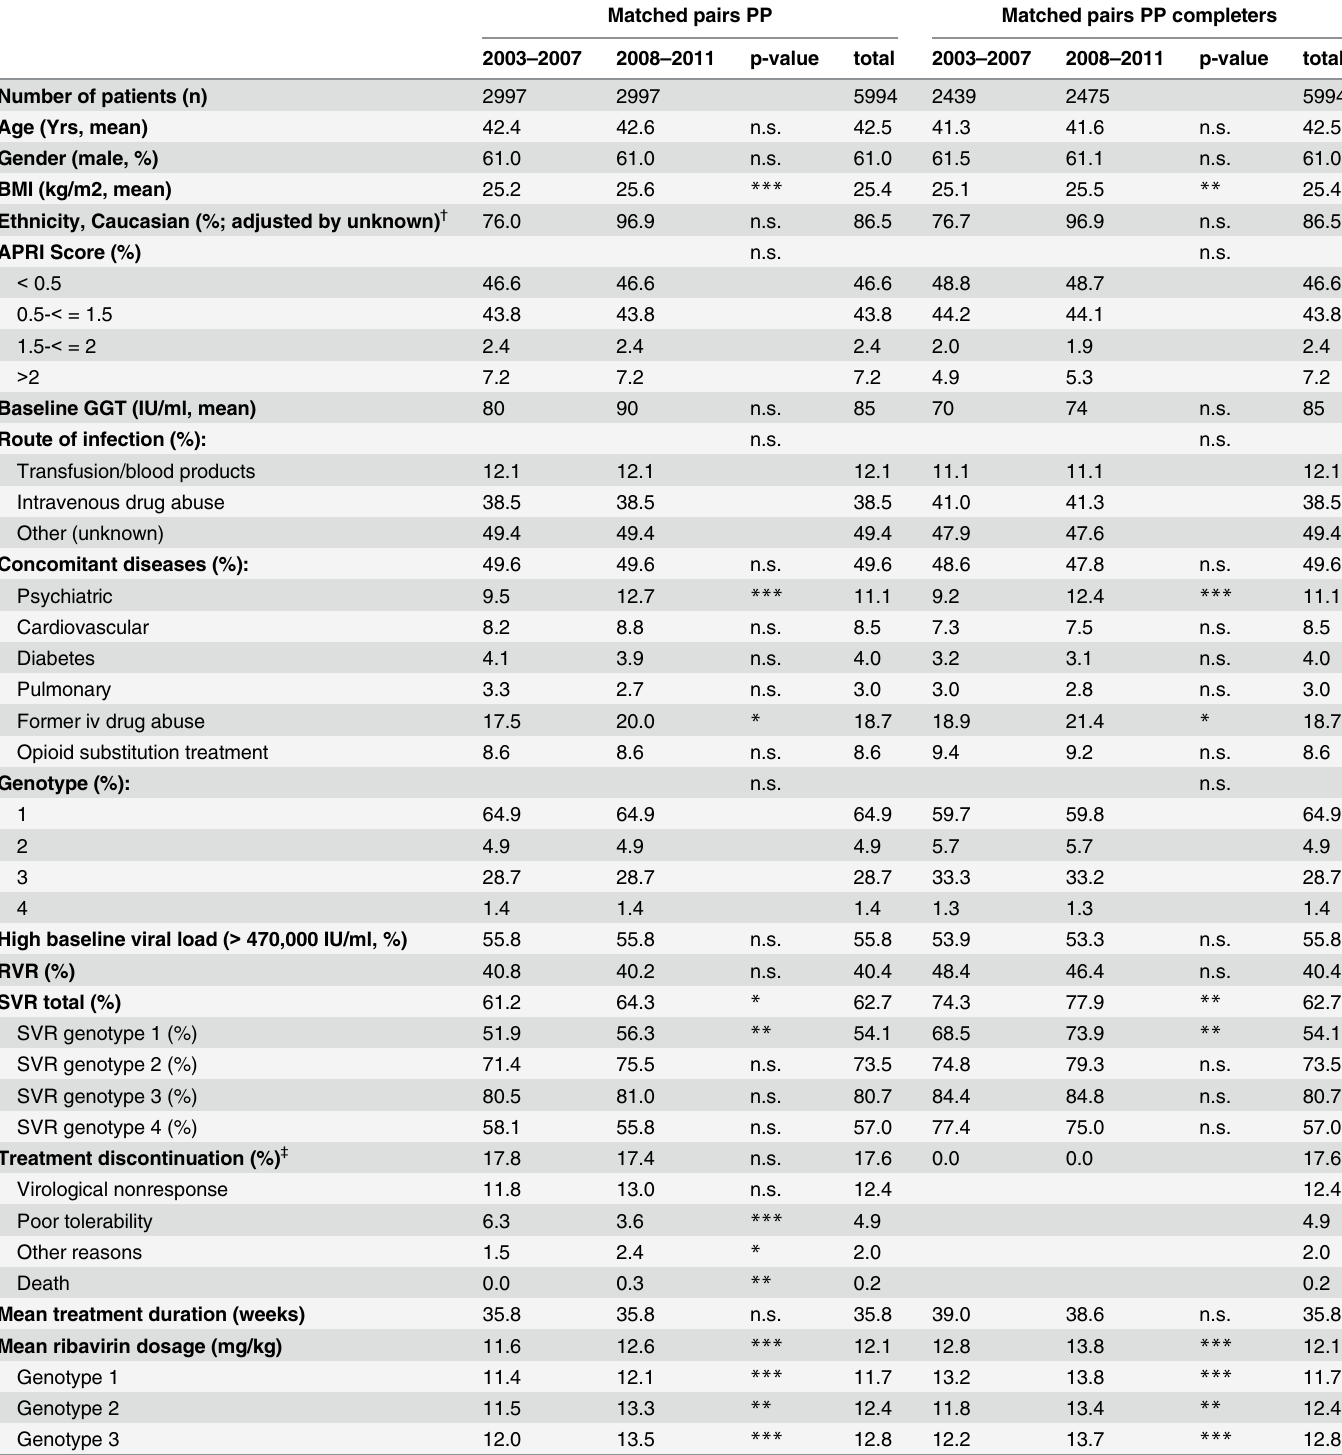
Table 2. Baseline demographics, virological responses, treatment discontinuations as well as treatment duration and mean ribavirin dose in two periods of 2003 – 2007 and 2008 – 2011 in the matched pairs PP and matched pairs PP completer